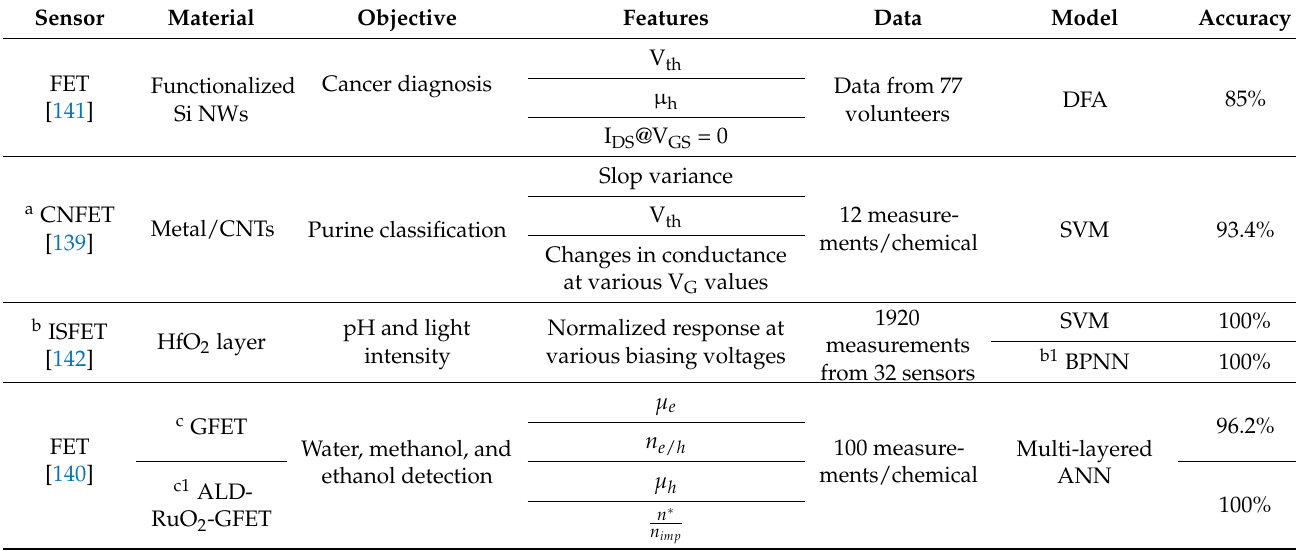
were 96.2% and 100%, respectively. The cross-validation results indicated that the pristine GFET device had a mean accuracy of 95.4% and a standard deviation of 2.5%, whereas the ALD-RuO 2 -GFET device had a mean accuracy of 99.6% and a standard deviation of 0.8%. [140]. A comparison of FET devices with extracted features and output accuracies is Table 2. A comparison of some of the reported extracted features and output accuracies for FET devices. Sensor